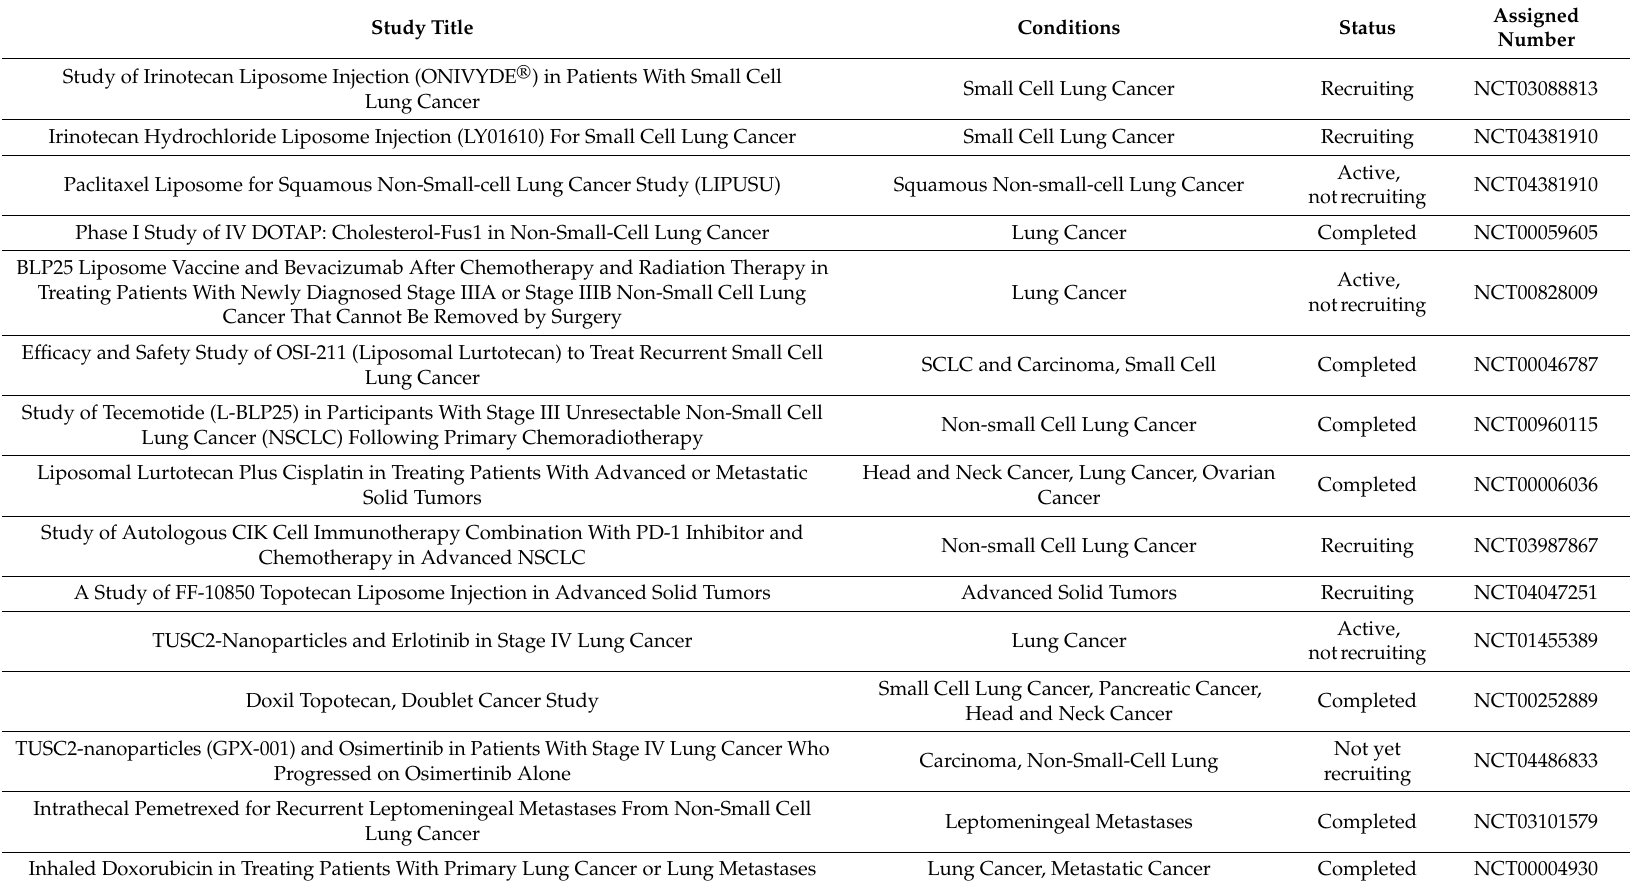
Table 4. Clinical trial studies of lung cancer therapies using lipid